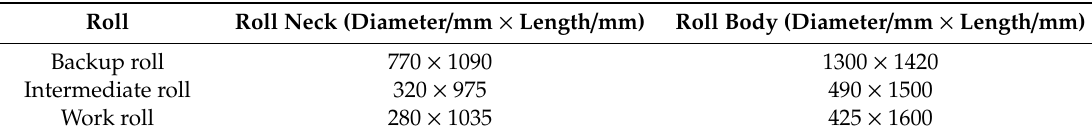
Figure 1. Universal Crown Mill with Work roll shifting (UCMW) roll system finite element model. Table 1. The main parameters of roll system. Table 1. The main parameters of roll system.